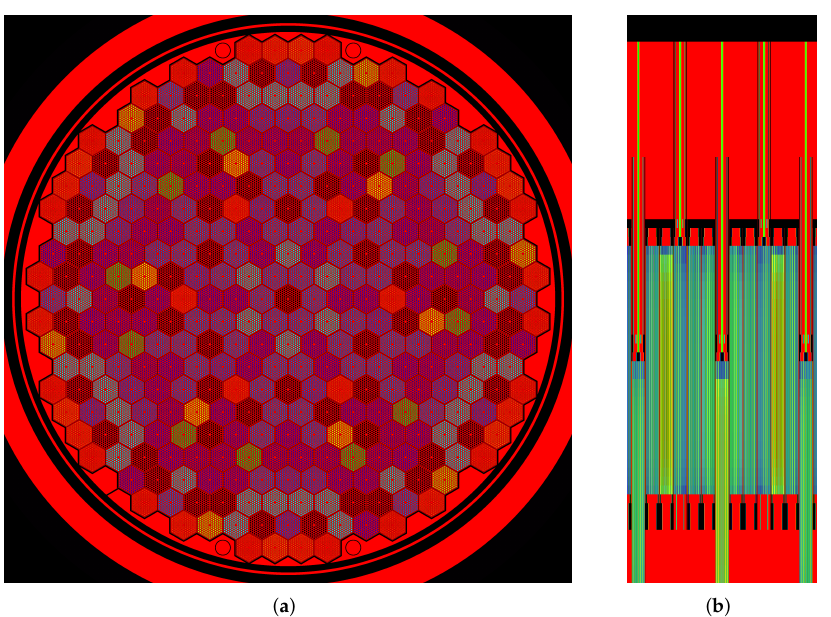
Figure 2. ( a ) VVER core model (with burnup) transaxial slice and ( b ) axial slice, different colours indicate different material composition.